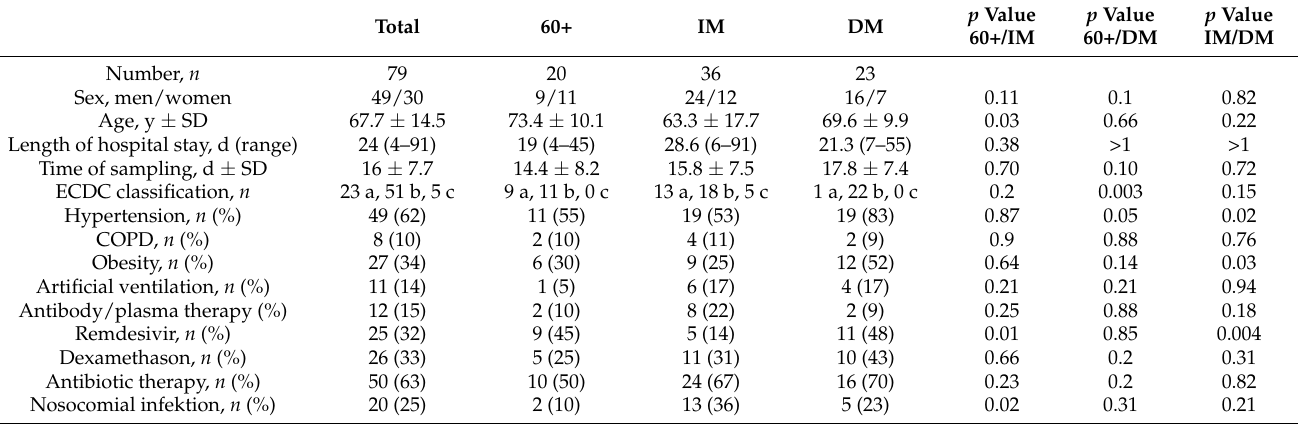
Table 1. Characteristics of the total patient cohort with three subgroups: elderly (60+), immuno- compromised (IM) and diabetes (DM) patients. Patients were classified according to the COVID-19 category given by the European Centre for Disease Prevention and Control (ECDC) classification among all cases: hospitalization (a), severe hospitalization (b), and death (c). Comparison between sex, age, length of hospital stay in days, time of sampling, ECDC criteria, hypertension, COPD, obesity, artificial ventilation, antibody/plasma therapy, Remdesivir and dexamethason therapy of the patients was performed with an independent t -test. Statistical significance was set at the level of p < 0.05. p Value Total 60+ IM DM 60+/IM